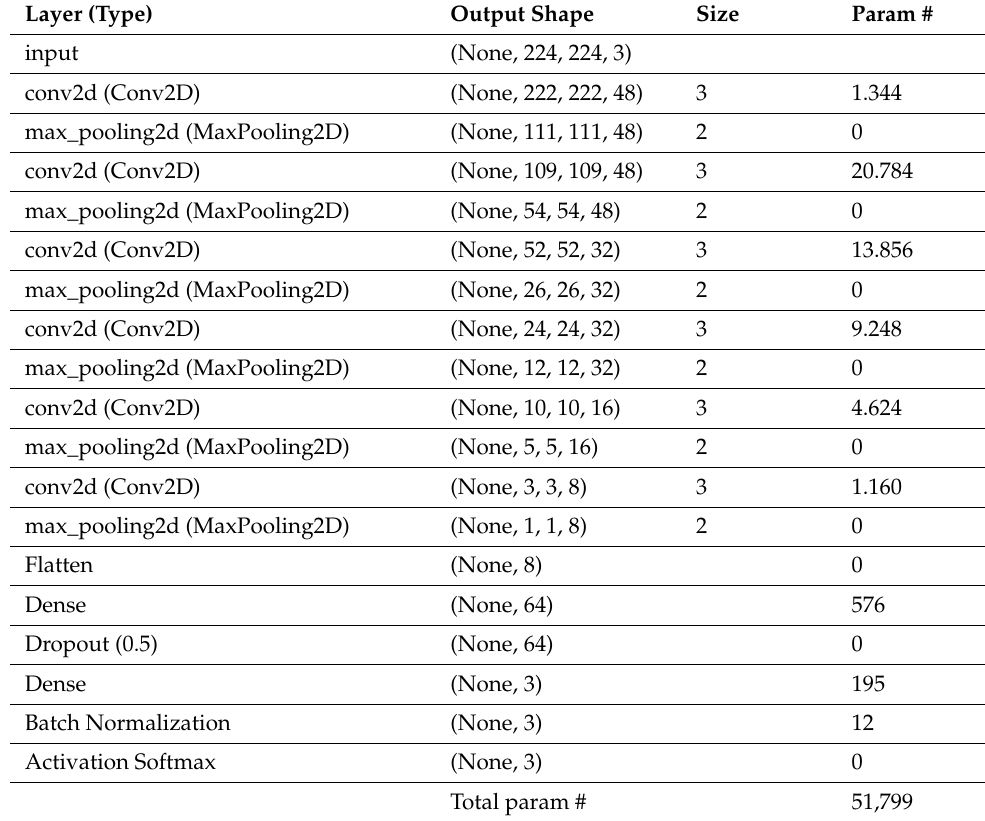
Table 2. Characteristics of the designed cnn.